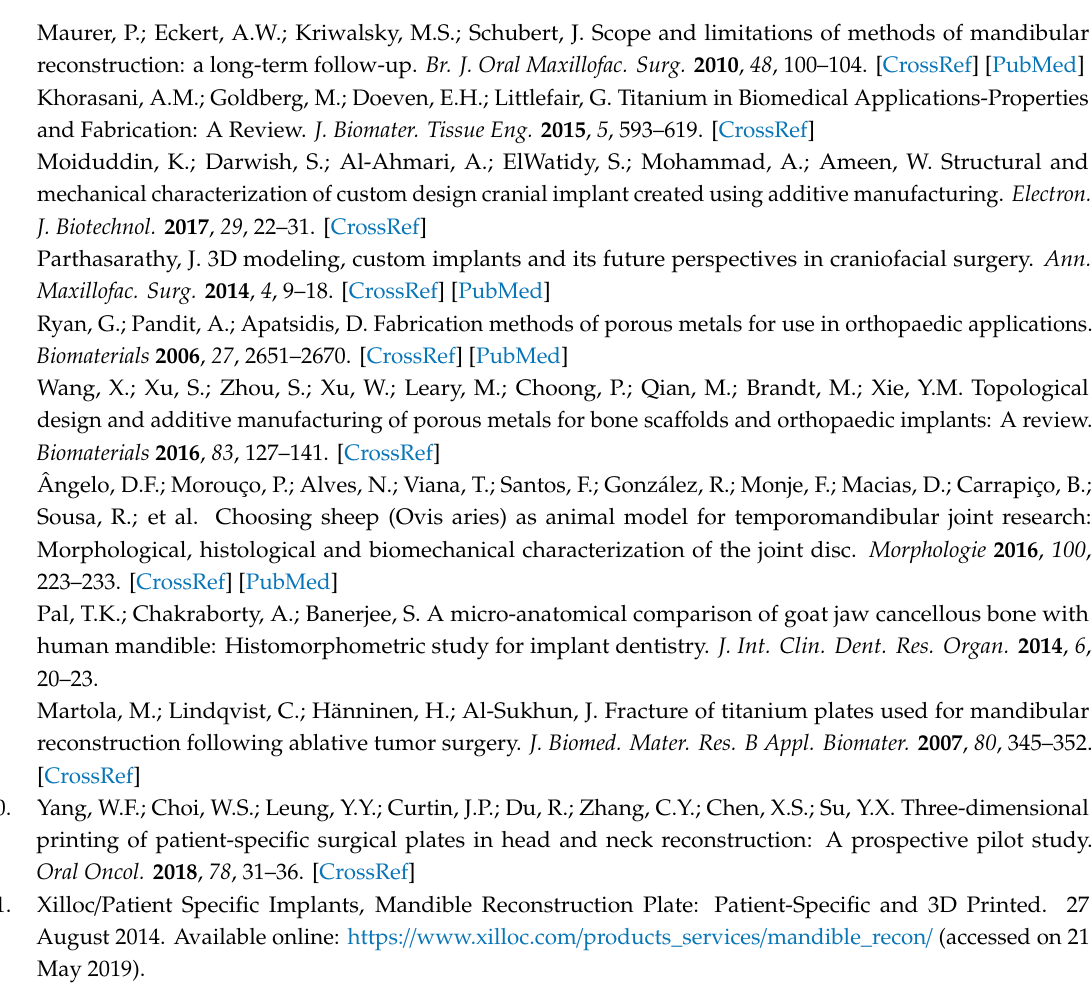
Table ST1: Implant cost calculation spreadsheet for Electron beam melting, Table ST2. Price calculation of major EBM spare parts